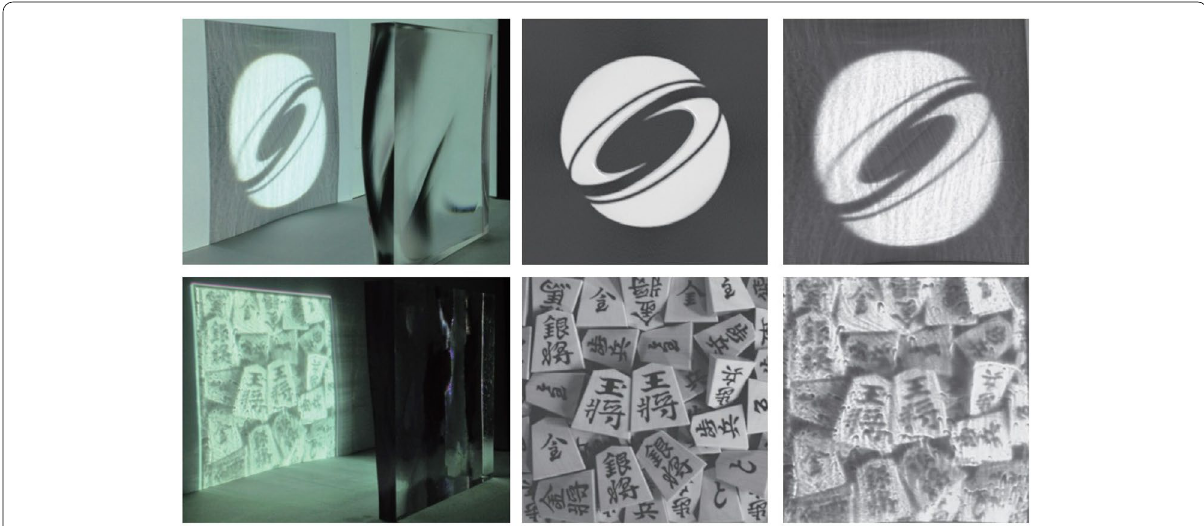
Fig. 20 Yue et al.[41] used a prism to refract light into the desired pattern. From left to right: the result of their method, the target images, and the caustic